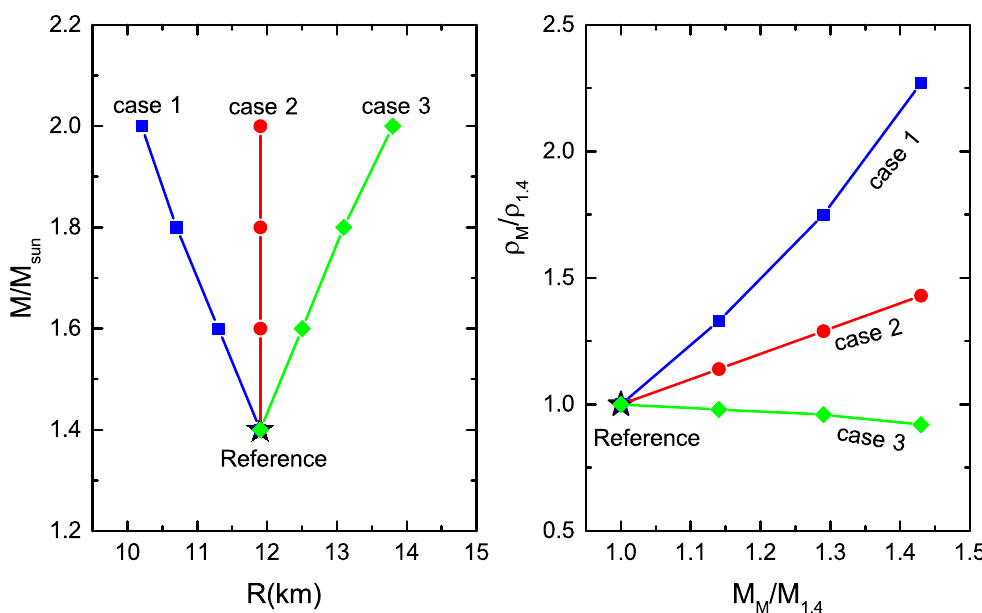
Figure 9. ( Left ) Representative mocked mass–radius correlations considered for massive NSs with respect to the reference of R 1.4 = 11.9 ± 1.4 km at a 90% confidence level for canonical NSs from GW170817. ( Right ) The corresponding average density in NSs of mass M scaled by that of canonical NSs as a function of the mass ratio M / M 1.4 . Taken from